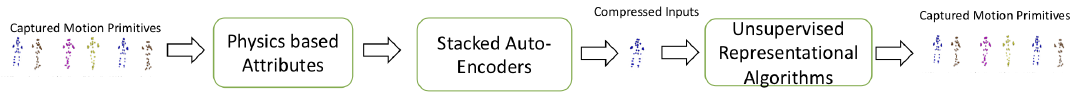
Figure 3. The proposed architecture for video dance summarization using stacked auto-encoders and representative